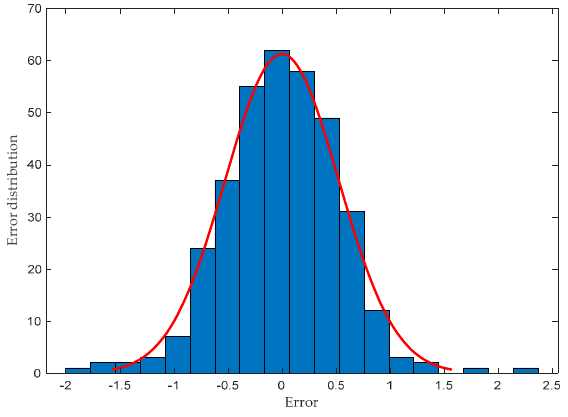
Figure 12. Error distribution of ER series.